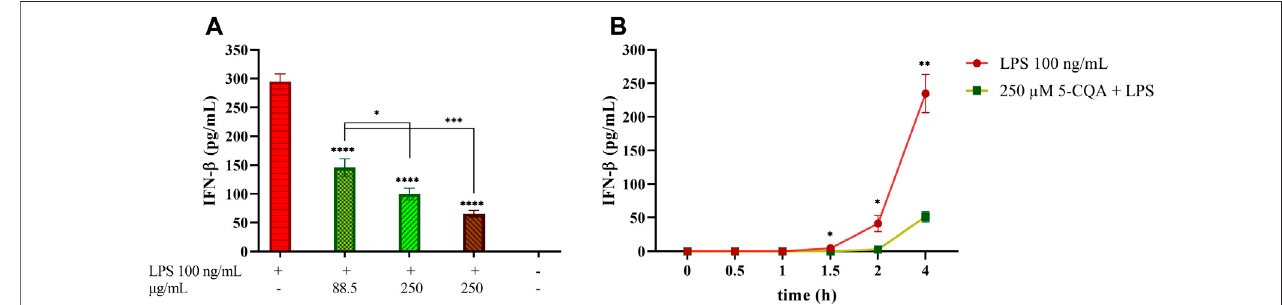
FIGURE 4 | Effect of coffee extract and 5-CQA on THP-1-derived macrophages release of IFN- β upon LPS stimulation. (A) TDM cells were pre-treated with 88.5 μ g/ml 5-CQA (dark green, square pattern), 250 μ g/ml GCE (light green, down-up diagonal pattern) and 250 μ g/ml RCE (brown, up-down diagonal pattern) for 1 h and then challenged with 100 ng/ml LPS. Supernatants were collected after 3 h. IFN- β released in the medium was quanti fi ed via ELISA. (B) THP-1-derived macrophages (TDM) cells were pre-treated with 250 μ M 5-CQA (green squares) for 1 h and then challenged with 100 ng/ml LPS. TDM treated with LPS only are depicted in red circles. Supernatants were collected at different time points (0 – 4 h). IFN- β released in the medium was quanti fi ed via ELISA. Data are represented as mean ± SEM of three independent experiments ( n = 3) (one-way ANOVA, * p < 0.05, ** p < 0.01, *** p < 0.001, **** p <